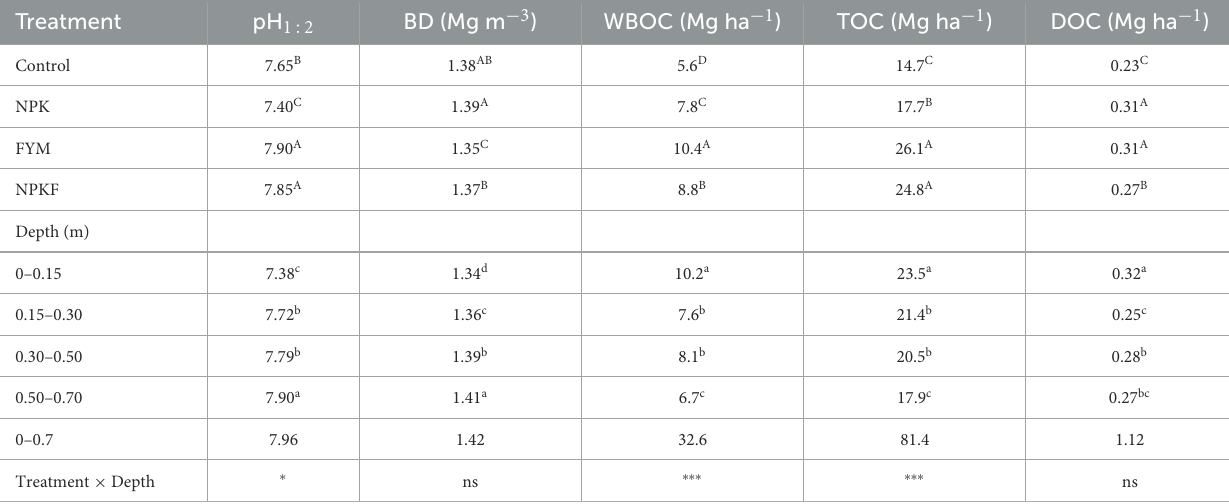
TABLE 2 Changes in soil physicochemical properties with nutrient management (mean over depths) and soil depth (mean over treatments). Treatment